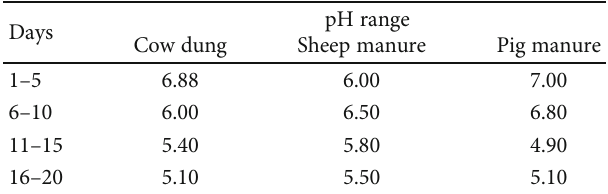
Table 3: Range of pH in animal manure